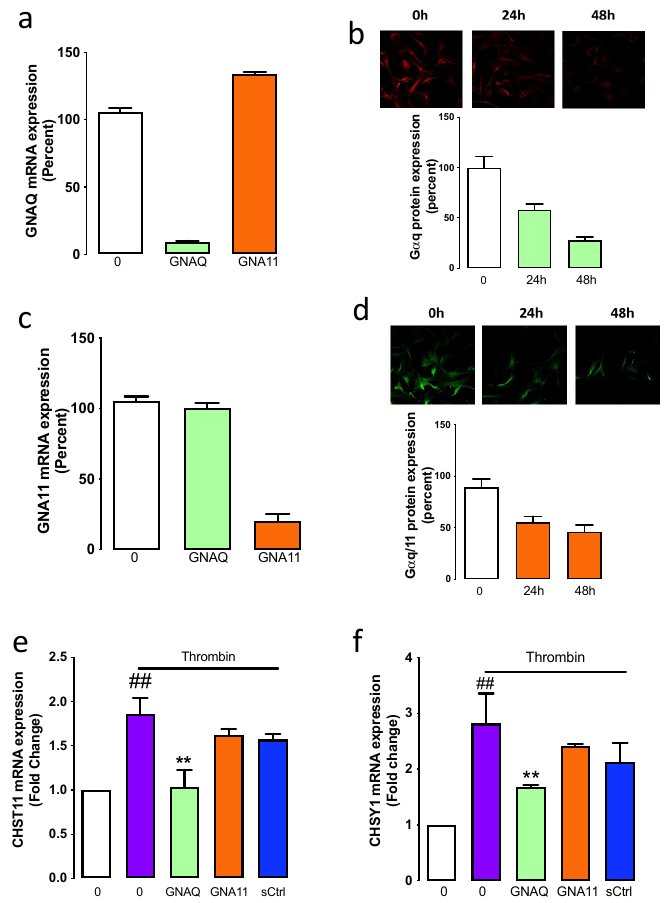
Figure 3. Silencing of GNAQ but not GNA11 is associated with thrombin-mediated stimulation of CHSY1, and CHST11. GNAQ and GNA11 were silenced in VSMCs. The mRNA expression of ( a ) GNAQ and ( c ) GNA11 were analysed after 48 h post-transfection. Data are expressed as the mean and standard error of the mean from two independent experiments. Fixed cells were incubated with ( b ) anti-G α q or ( d ) anti-G α q/11 overnight, followed by goat anti-rabbit conjugated with Alexa488 or Alexa594. Images are representative of two independent experiments. Histograms represent the mean intensity of cells presented in 5 field views. Data expressed as mean ± standard error of the mean. The mRNA expression of ( e ) CHST11 and ( f ) CHSY1 were assessed in GNAQ, GNA11 or scramble siRNA (sCtrl) silenced cells treated with Thrombin. Results are the mean and standard error from three separate experiments. Statistical significance was determined by one-way ANOVA, followed by least significant difference post hoc analysis ##, p < 0.01 basal versus thrombin and **, p < 0.01 thrombin versus